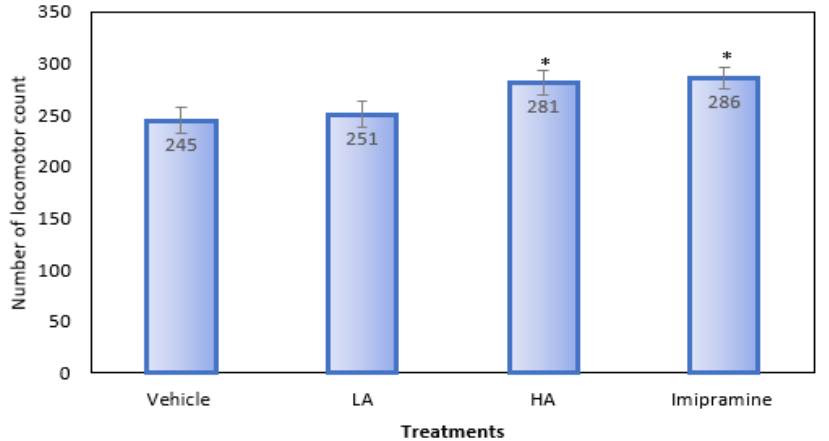
Figure 3. The effect of apigenin and imipramine on the number of locomotor counts. Data are ex- pressed in mean ± SEM (n = 8). Data were evaluated using a one-way analysis of variance (ANOVA) and Tukey ’ s test. * p < 0.05 when compared to the vehicle control group. LA: low dose of Apigenin (25 mg/kg); HA: high dose of Apigenin (50 mg/kg); Imipramine: standard antidepressant (15 mg/kg); Vehicle; 0.2% carboxy methyl cellulose (CMC).